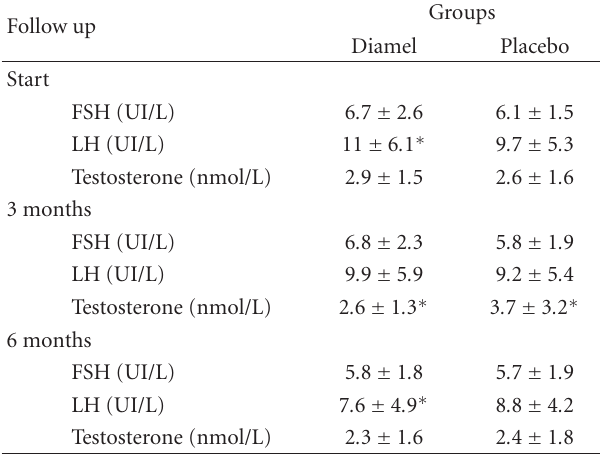
Table 8: Evolution of the hormone levels in patients with PCOS during the follow up period. Follow up